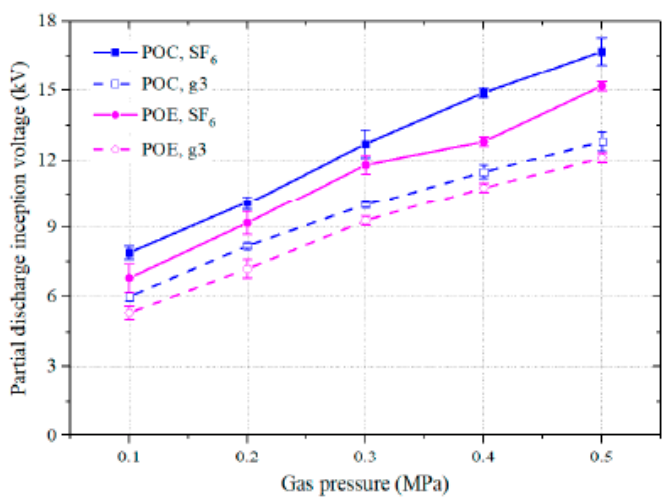
Figure 3. Partial discharge inception voltages of SF 6 and g3 in the protrusion defects [70].